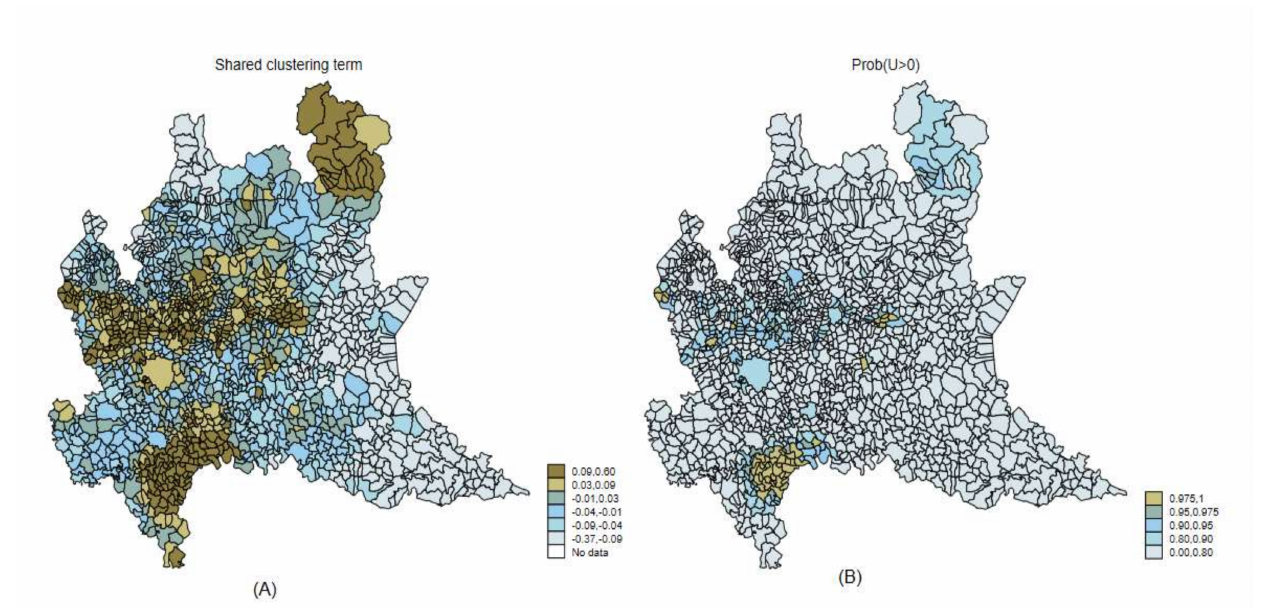
Figure 5. Maps of shared clustering terms (U) between pleural cancer and ovarian cancer from model 4 (M4) ( A ) and Posterior Probability of Direction of Effect—Prob (U > 0) ( B ). Lombardy Region, 2000–2018.